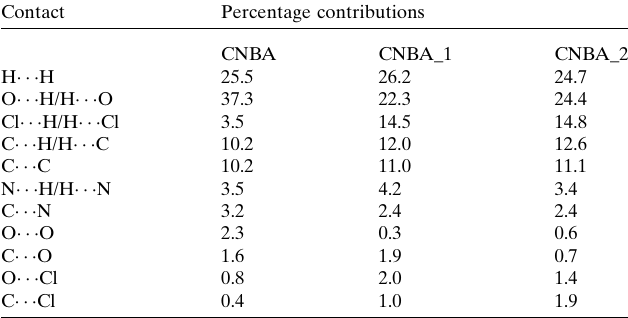
Table 2 Percentage contributions of interatomic contacts to the Hirshfeld surface for CNBA, and for the individual disordered components, CNBA_1 and CNBA_2. Contact